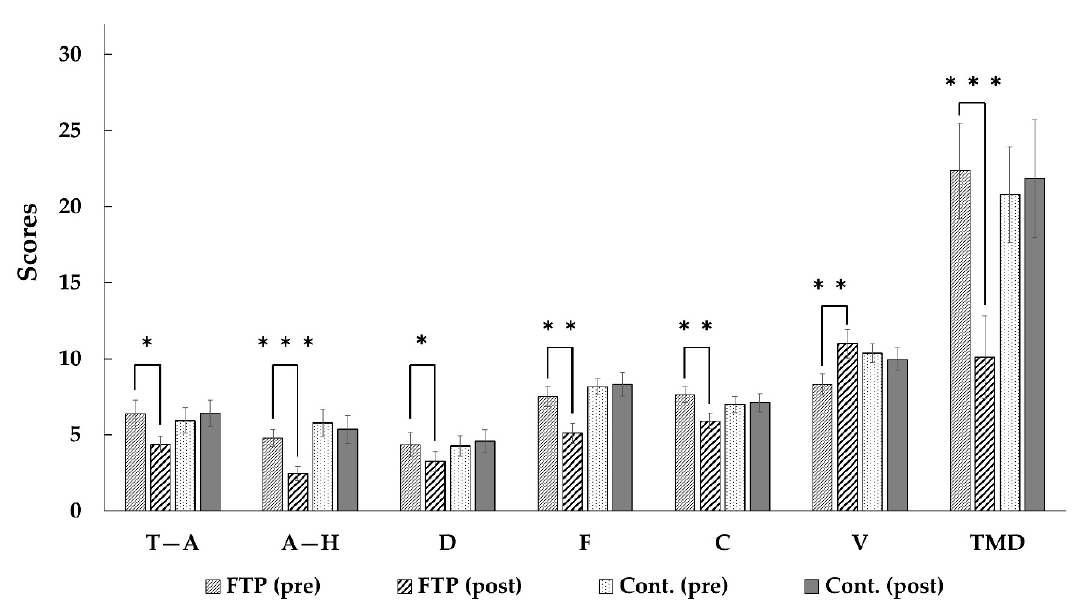
Figure 2. The results of paired t -test analyses of Profile of Mood States (POMS) scores. T–A = tension–anxiety; C = confusion; A–H = anger–hostility; D = depression; F = fatigue; V = vigor; TMD = Total Mood Disturbance. FTP = Forest Therapy Program Group; Cont. = Control Group. *** p < 0.001, ** p < 0.01, * p < 0.05 .